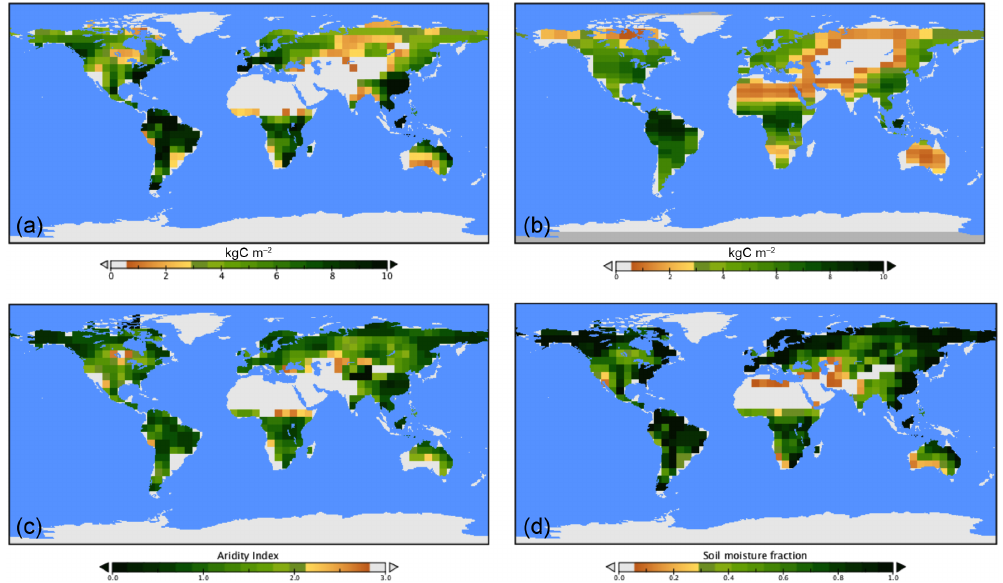
Figure 5. Land surface. (a) ENTS vegetation carbon density from PLASIM–GENIE, (b) ENTS vegetation carbon density from GENIE-1 (Holden et al., 2013a), (c) Budyko aridity index N/P and (d) soil moisture fraction E/N .